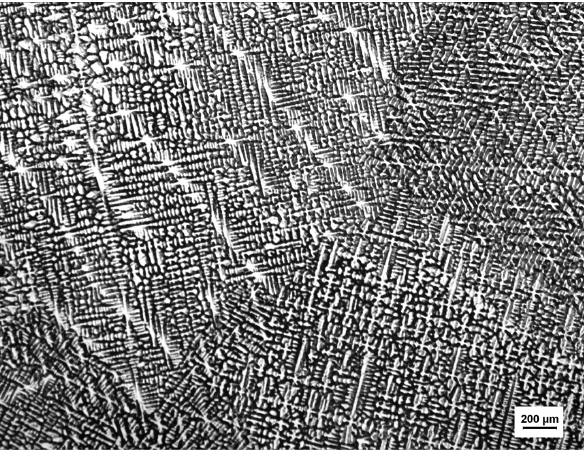
Figure 1: Microstructure of as received BFe10-1-2